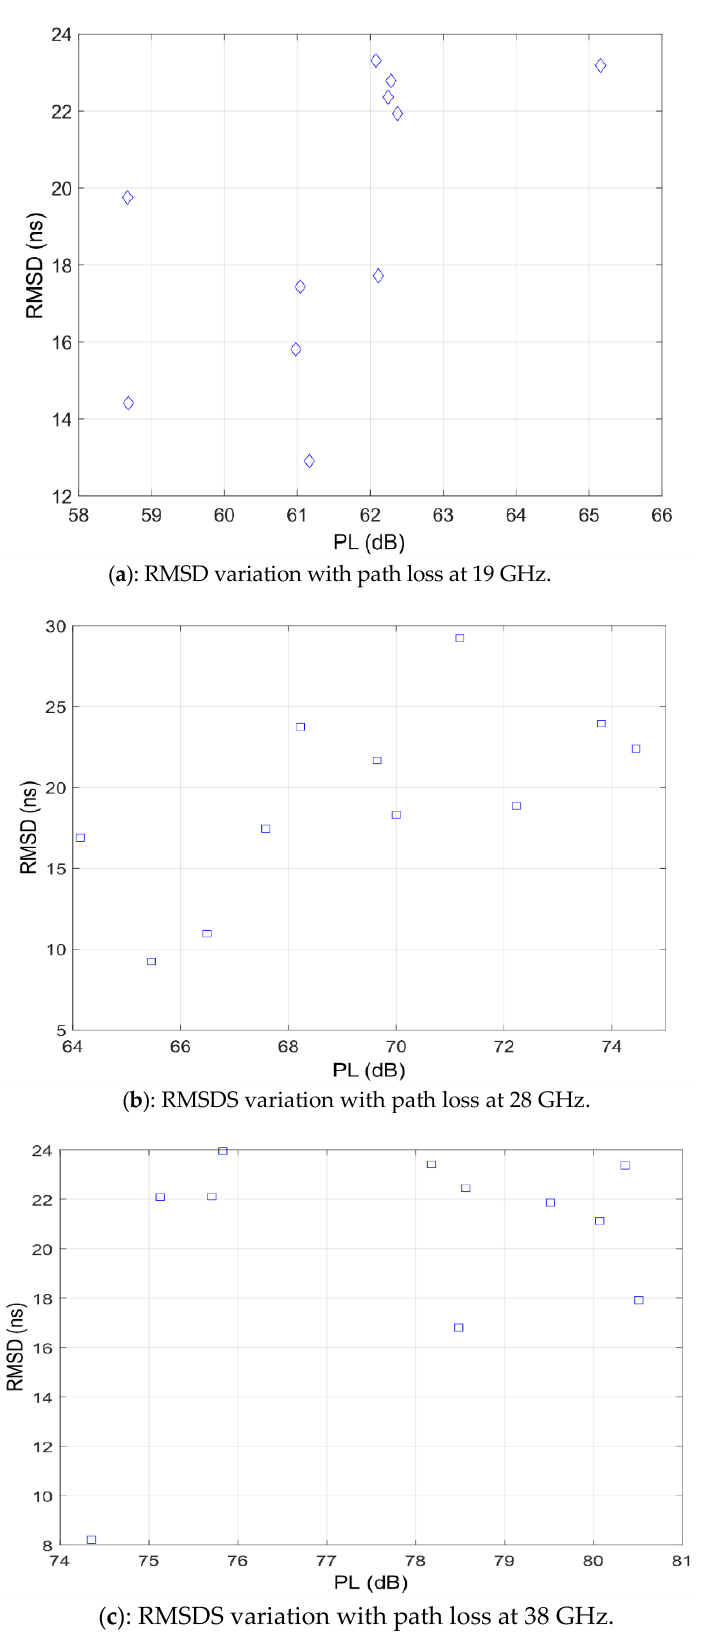
Figure 6. The spread of RMS delay as a function of path loss.